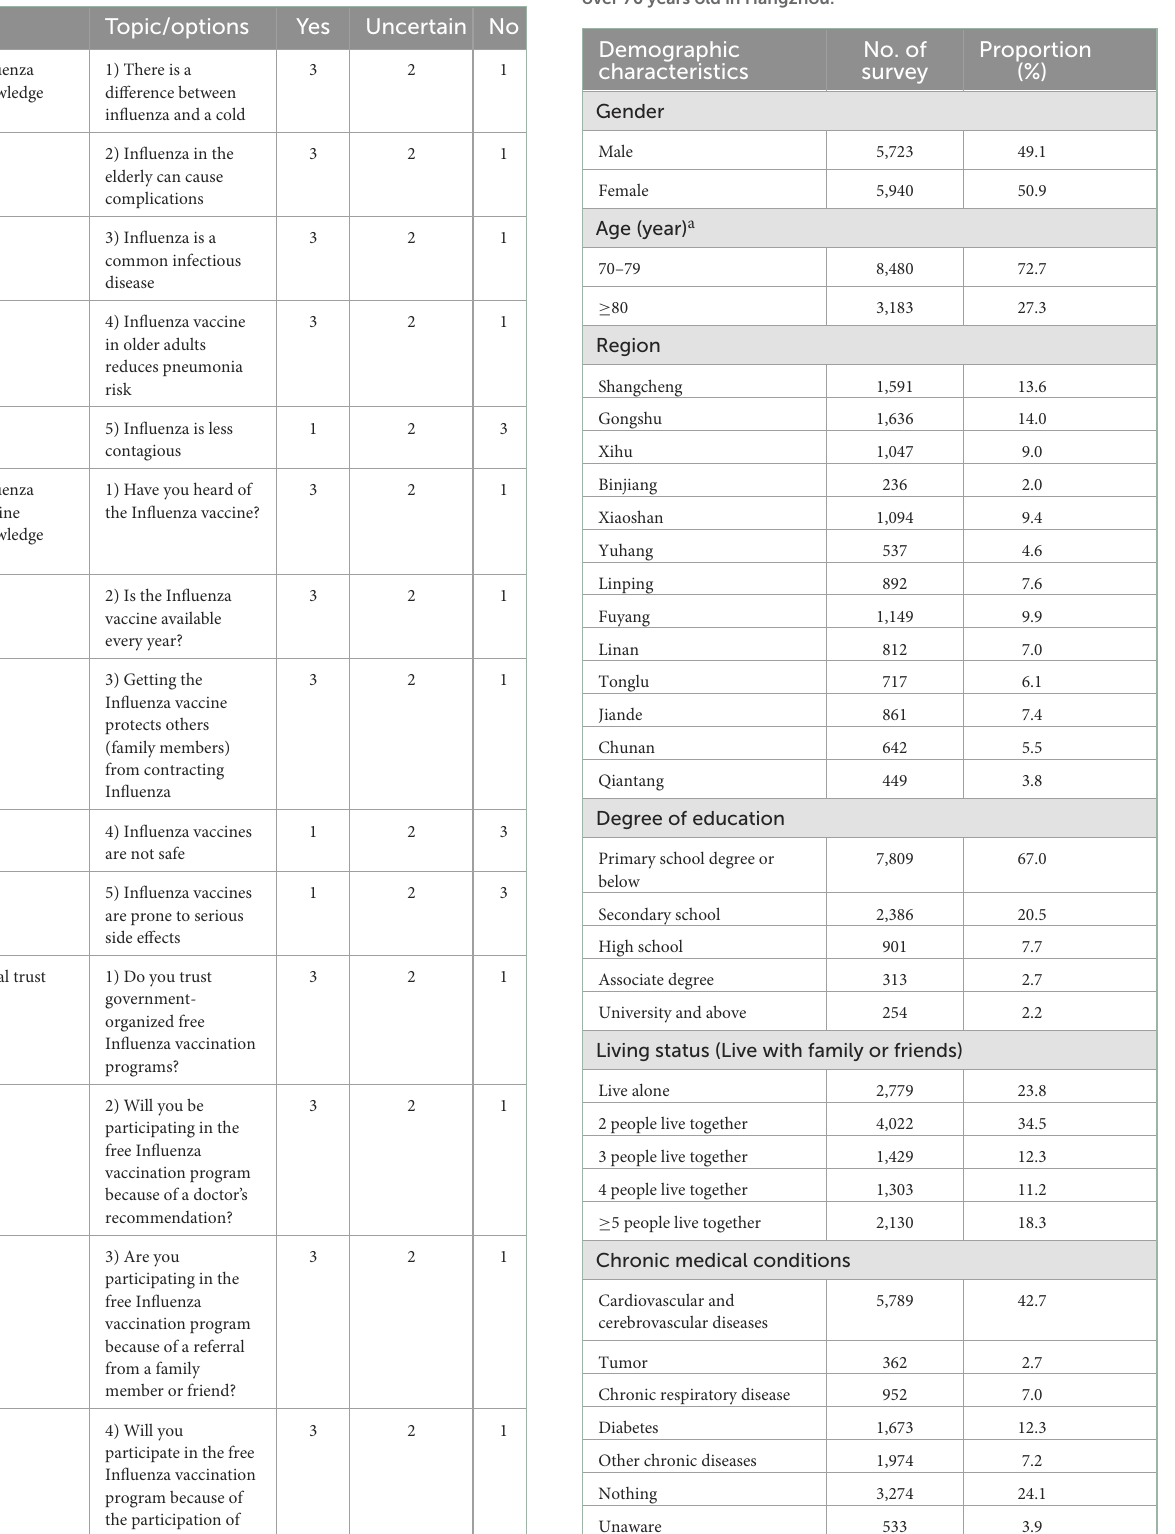
TABLE 1 Fixed scoring principles. TABLE 2 Survey on influenza vaccination intention among the elderly